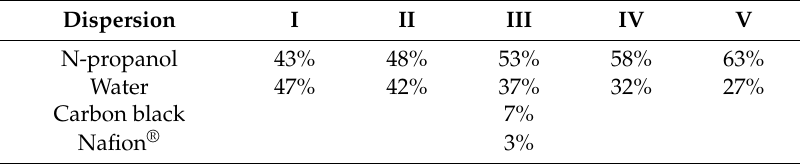
Table 1. Mass fractions of polymeric carbon-black dispersions that were used for the